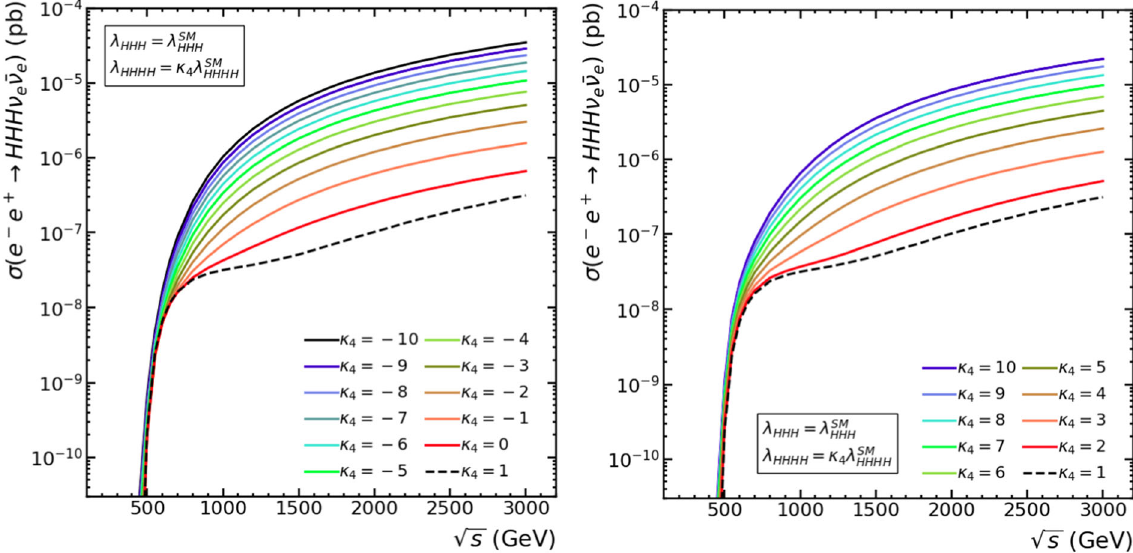
√ s for different values of the parameter κ 4 , with κ 3 fixed to 1,